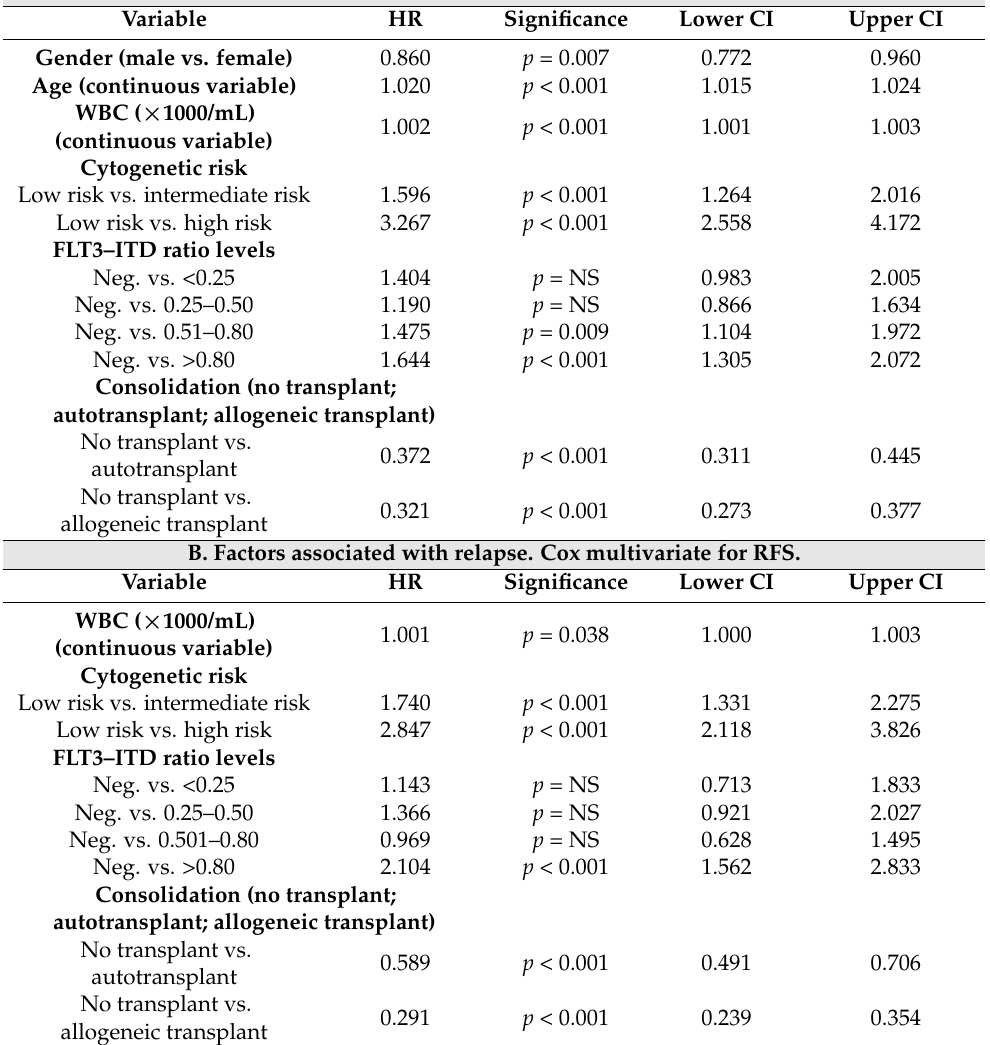
Table 4. Factors associated with death and leukemia relapse. Cox multivariate for OS and RFS. Effect of patient and disease characteristics on overall survival (OS) and relapse-free survival (RFS), and multivariate analyses (prognostic factors with p < 0.1 in univariate analysis were included). A. Factors associated with death. Cox multivariate for